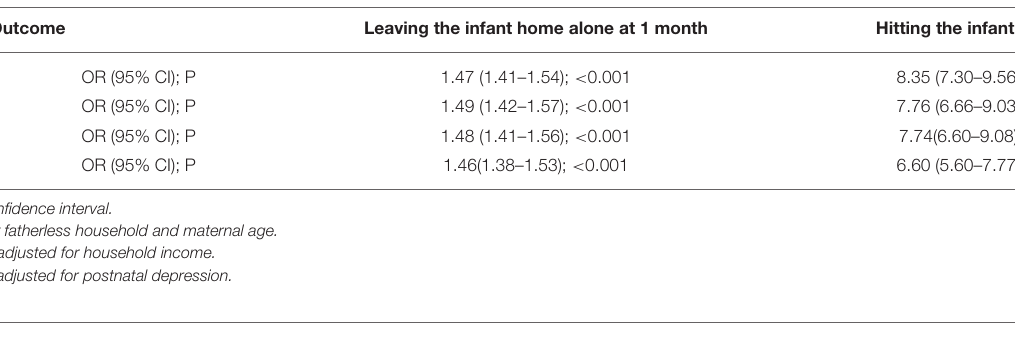
TABLE 3 | Association between shaking and inappropriate parenting behavior at 6 months postpartum: odds ratios and 95% confidence intervals.